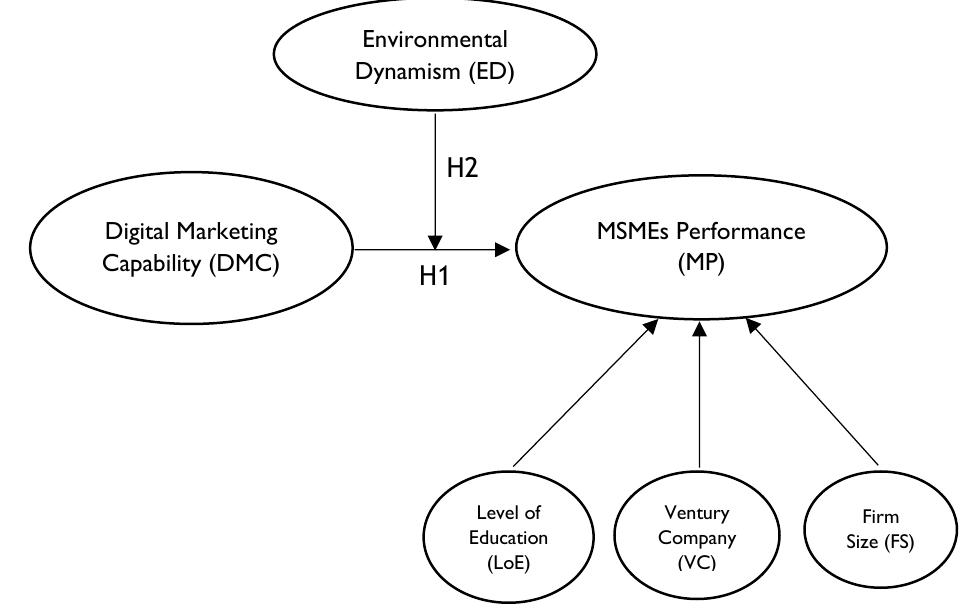
Figure 1. Research Conceptual